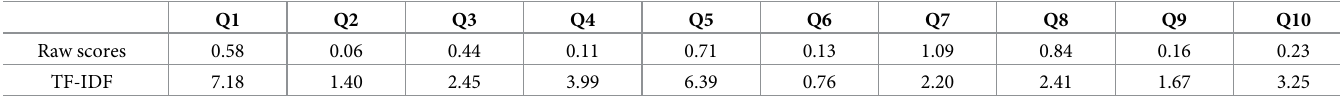
Table 6. KL divergence for JIHO dataset.